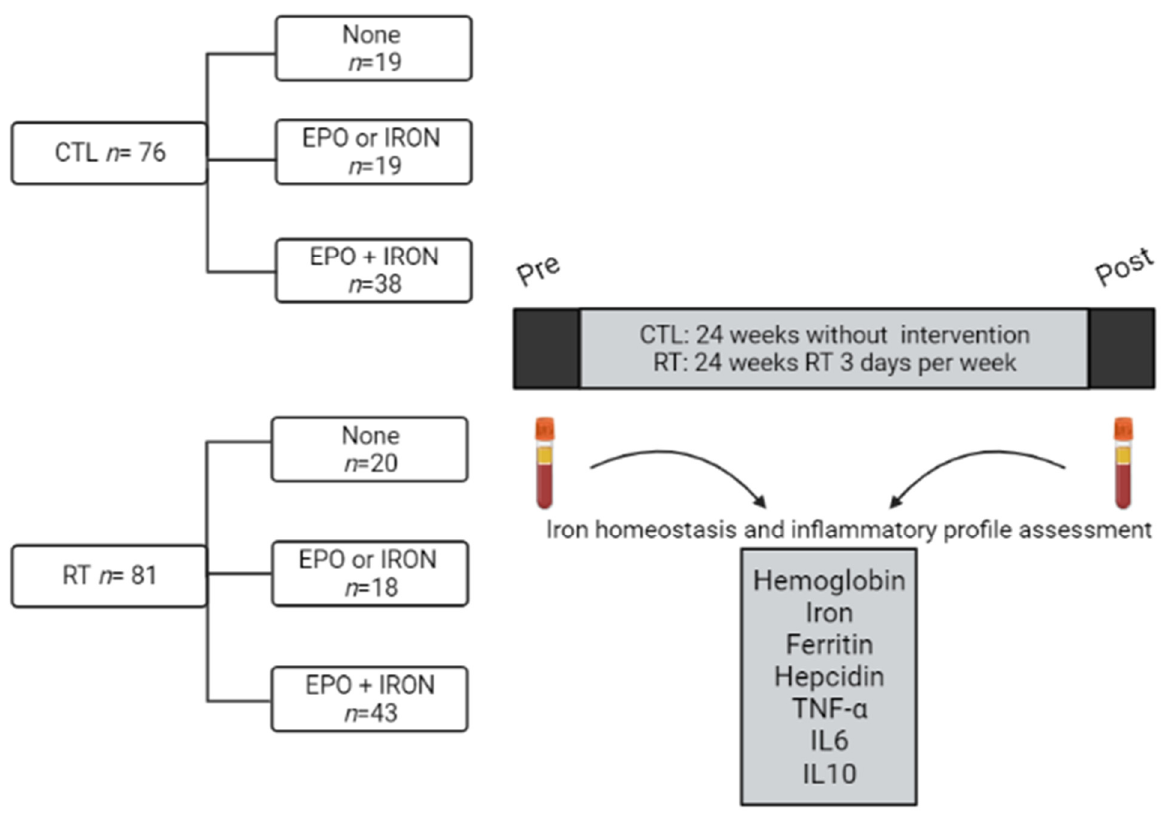
Figure 1. Experimental design. CTL: control group; RT: resistance training group; EPO: Erythropoietin; TNF: tumor necrosis factor; IL: interleukin.